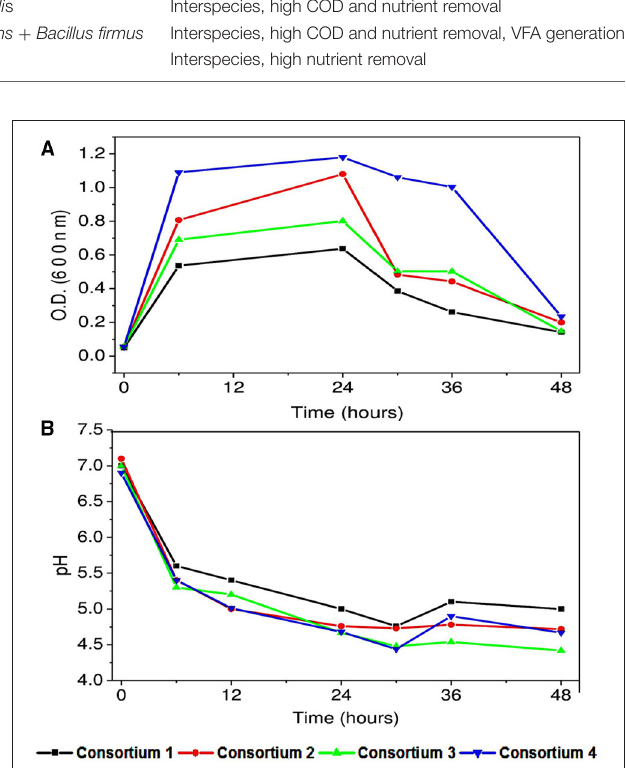
FIGURE 7 | (A) Bacterial growth of synthetic consortia in synthetic wastewater (B) pH variation with time with synthetic consortia.